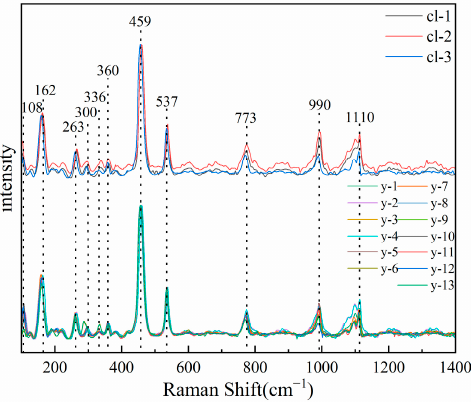
Figure 7. Raman spectra of colorless ( upper ) and yellow ( lower ) samples.